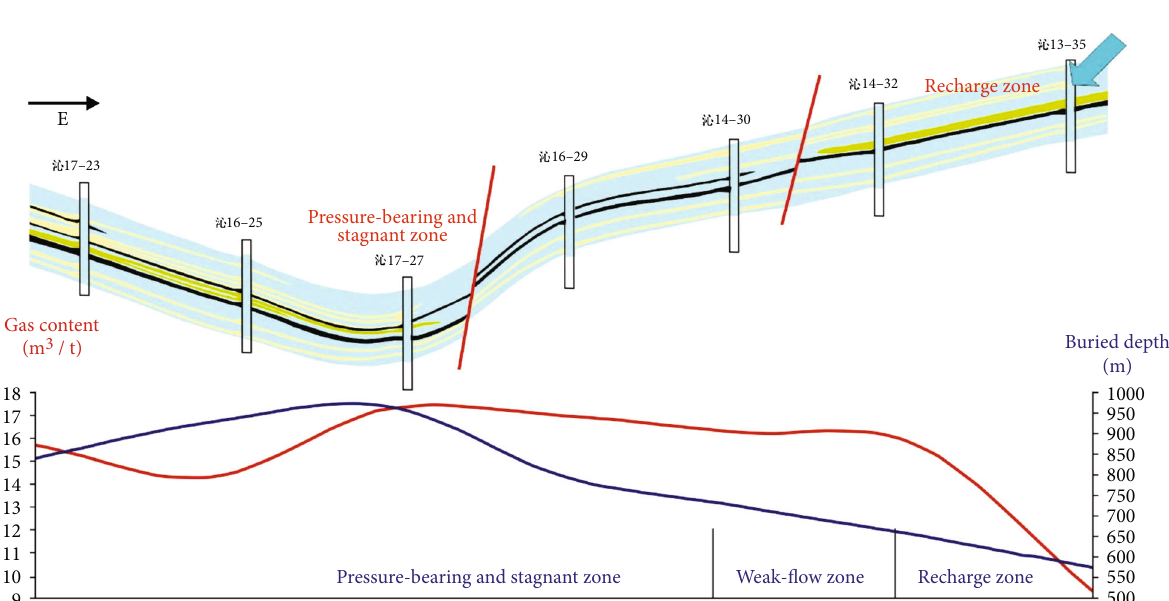
Figure 1: Analysis map of the accumulation model of the Qinnan-Xiadian